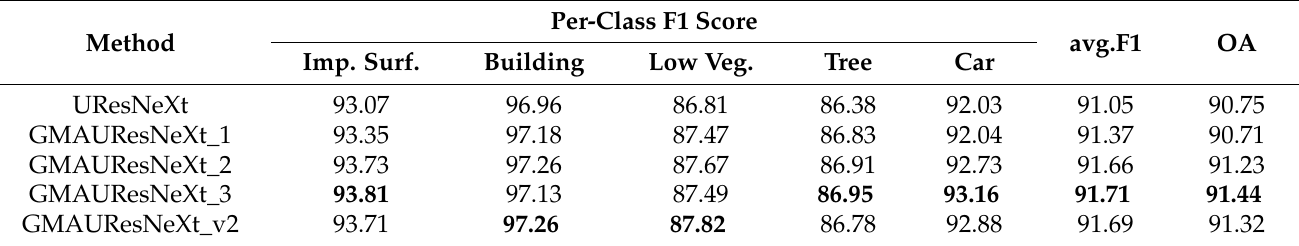
Table 5. The ablation study of the GAG on the ISPRS Potsdam